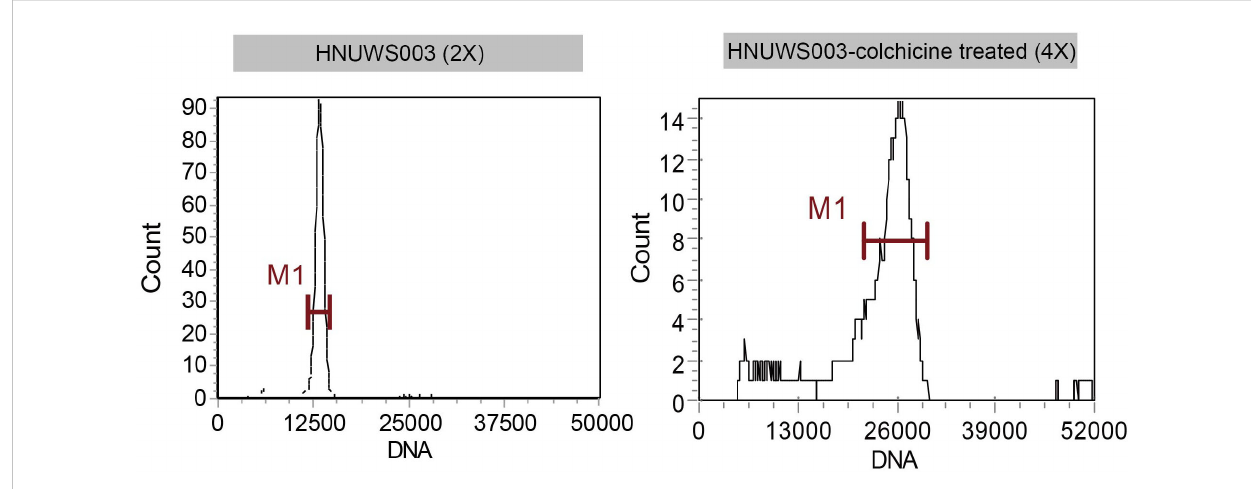
FIGURE 4 Histograms of fl ow cytometry fi nding for water